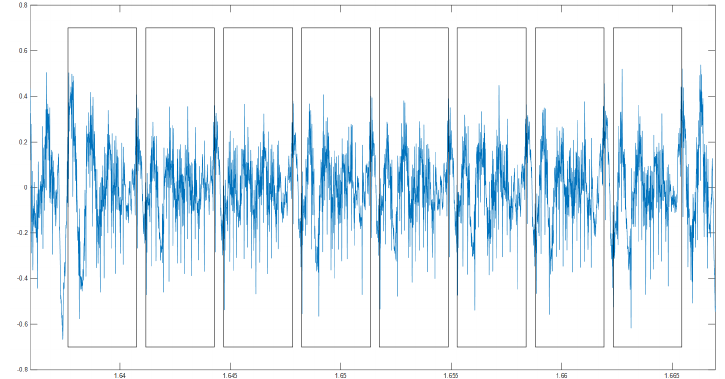
Figure 3. Beginning of a field multiplication power consumption trace. Each w -bit multiplication subtrace in a field multiplication can be identified using simple power analysis (SPA) and